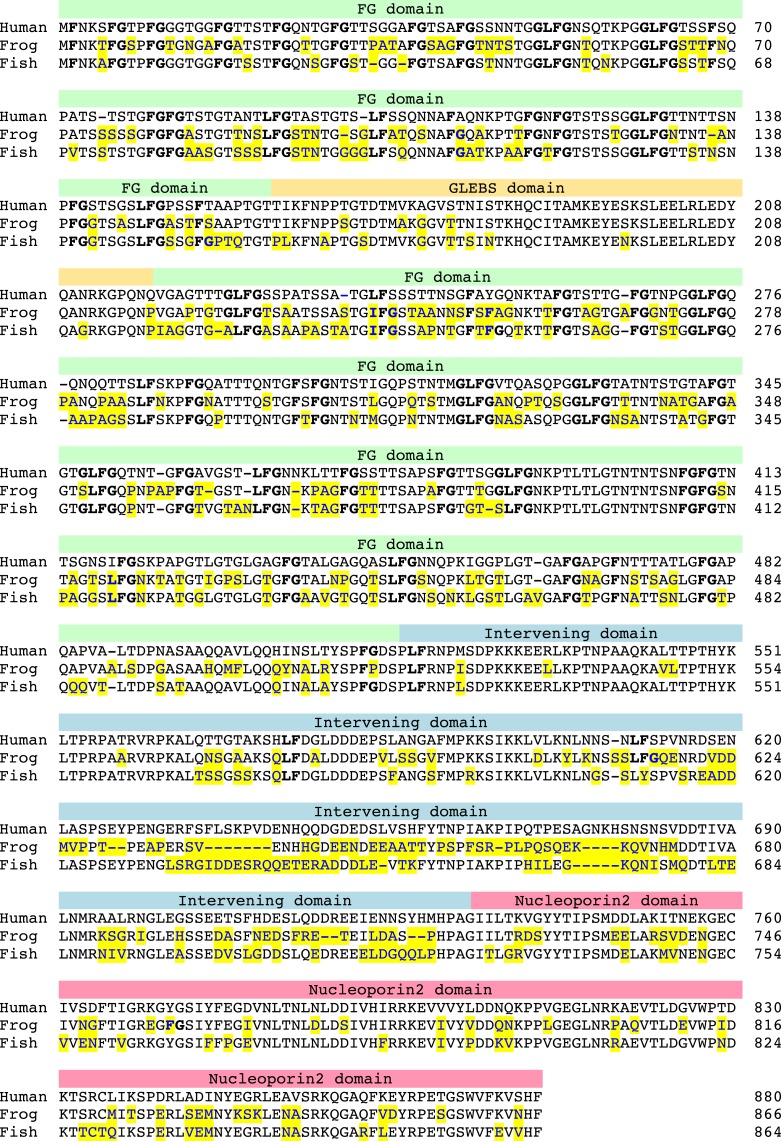
High sequence conservation of the Nup98 FG domain amongst vertebrates.Nup98 from human (GI: 530395413), the frog Xenopus tropicalis (GI: 523580018) and the fish Lepisosteus oculatus (GI: 573879996) were aligned. FG motifs are in bold; deviations from the human sequence are marked in yellow. The domain structure is annotated. Unlike typical intrinsically disordered domains, the Nup98 FG domain shows a similar conservation (≈70% identity) as the globular, folded nucleoporin2 domain (≈75% identity). The majority of exchanges between the FG domains are very conservative, that is mostly permutations between T, S, N, A, and to a lesser extent, with G. Please also note that many exchanges from the human sequence are identical in frog and fish, further supporting the notion of slow evolution.